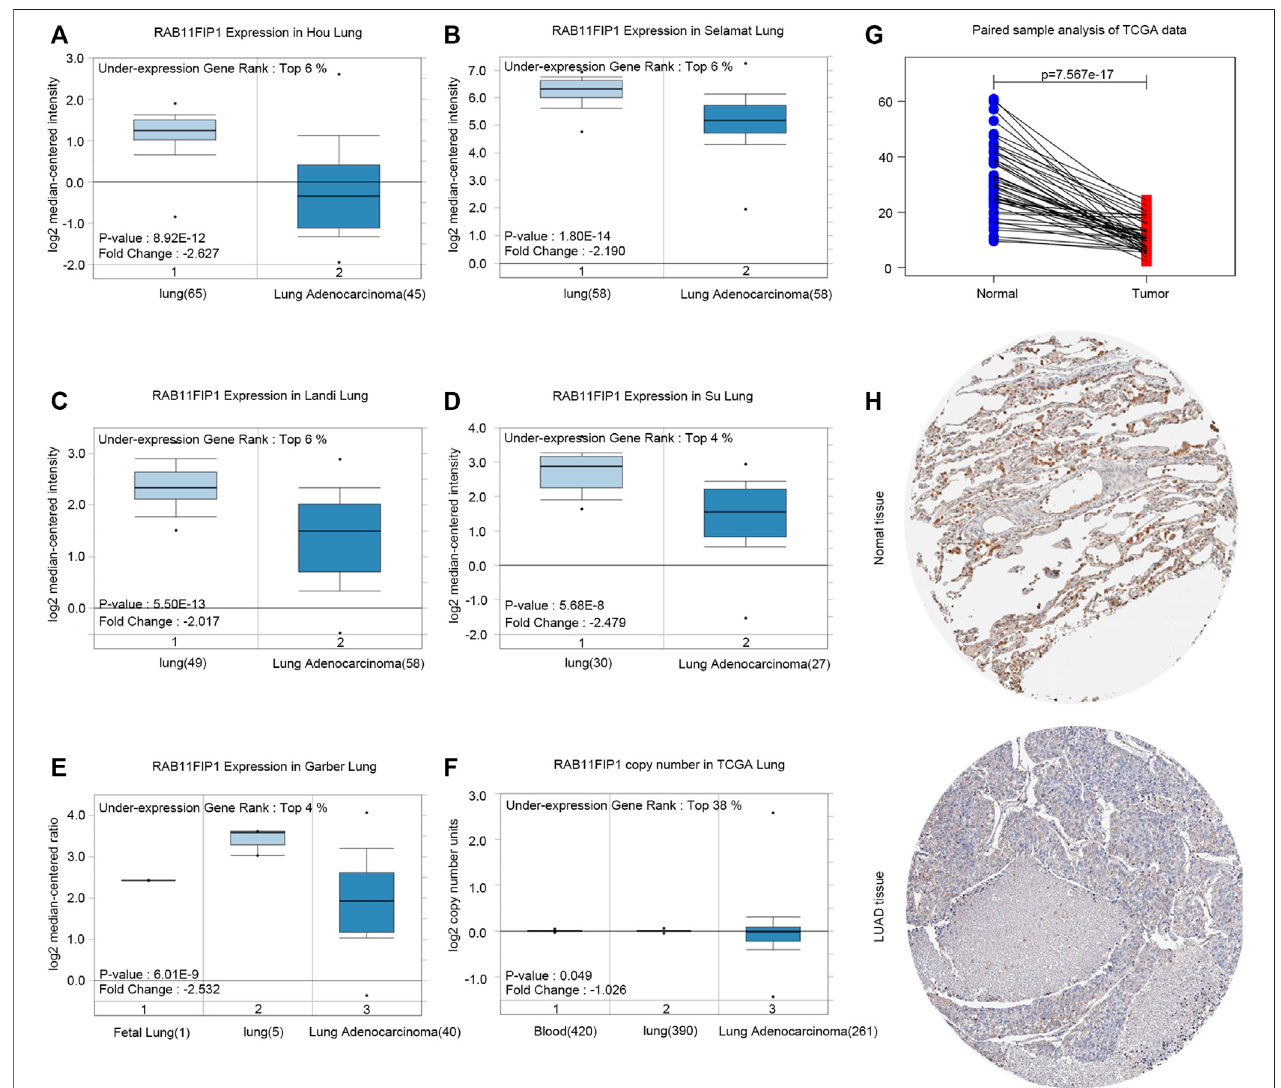
FIGURE 1 | RAB11FIP1 expression levels in LUAD. (A – E) Box plot showing RAB11FIP1 mRNA levels in Hou Lung, Selamat Lung, Landi Lung, Su Lung, Garber Lung datasets. (F) Box plot showing RAB11FIP1 copy number in TCGA Lung datasets, respectively. (G) The paired expression of RAB11FIP1 between normal and tumor tissues. (H) RAB11FIP1 protein levels in normal lung and LUAD were visualized by IHC in HPA.